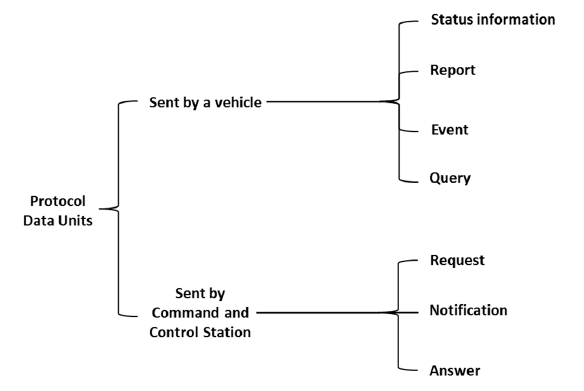
Figure 2. Taxonomy for the PDUs in MDTP.